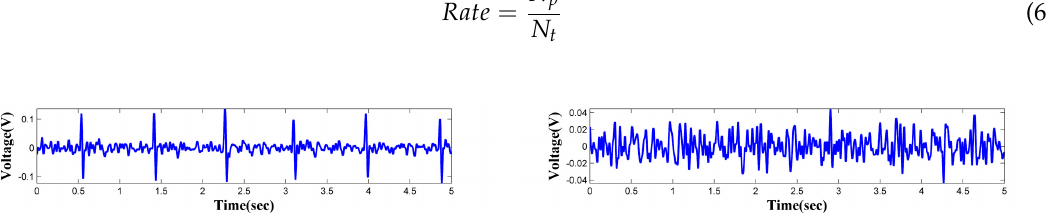
Figure 5. Systemic diagram.